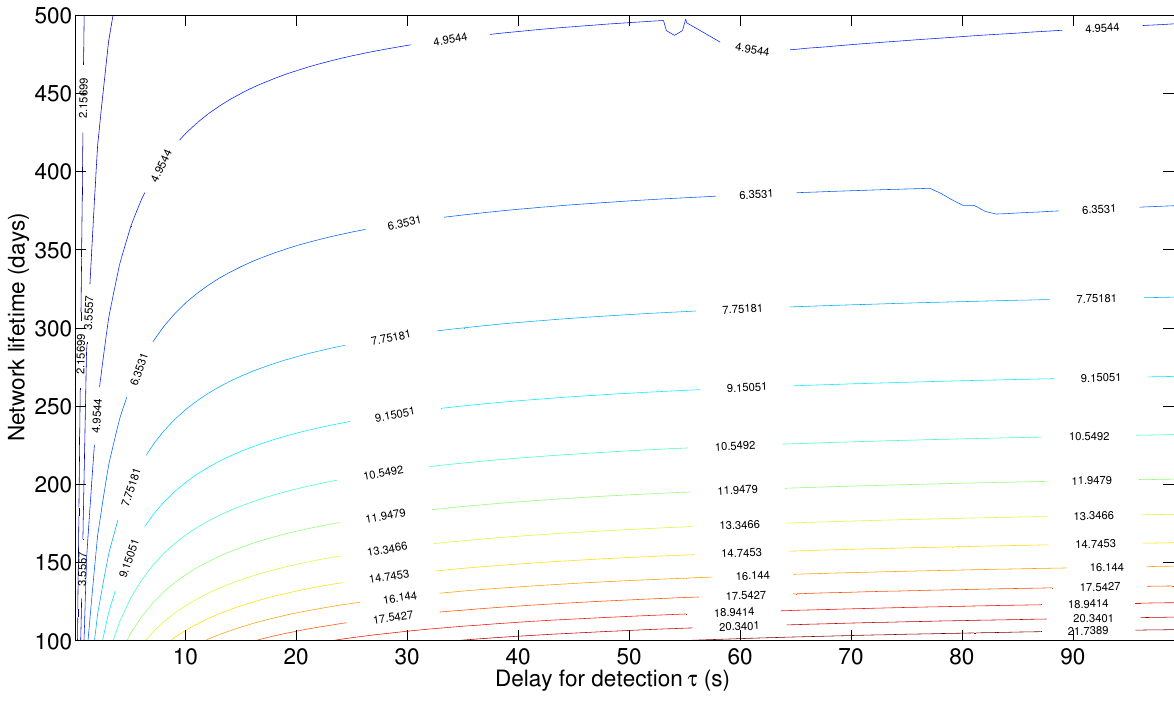
Figure 12. Contour plot for the deflection coefficient for the S-ALOHA-NR tree sensor